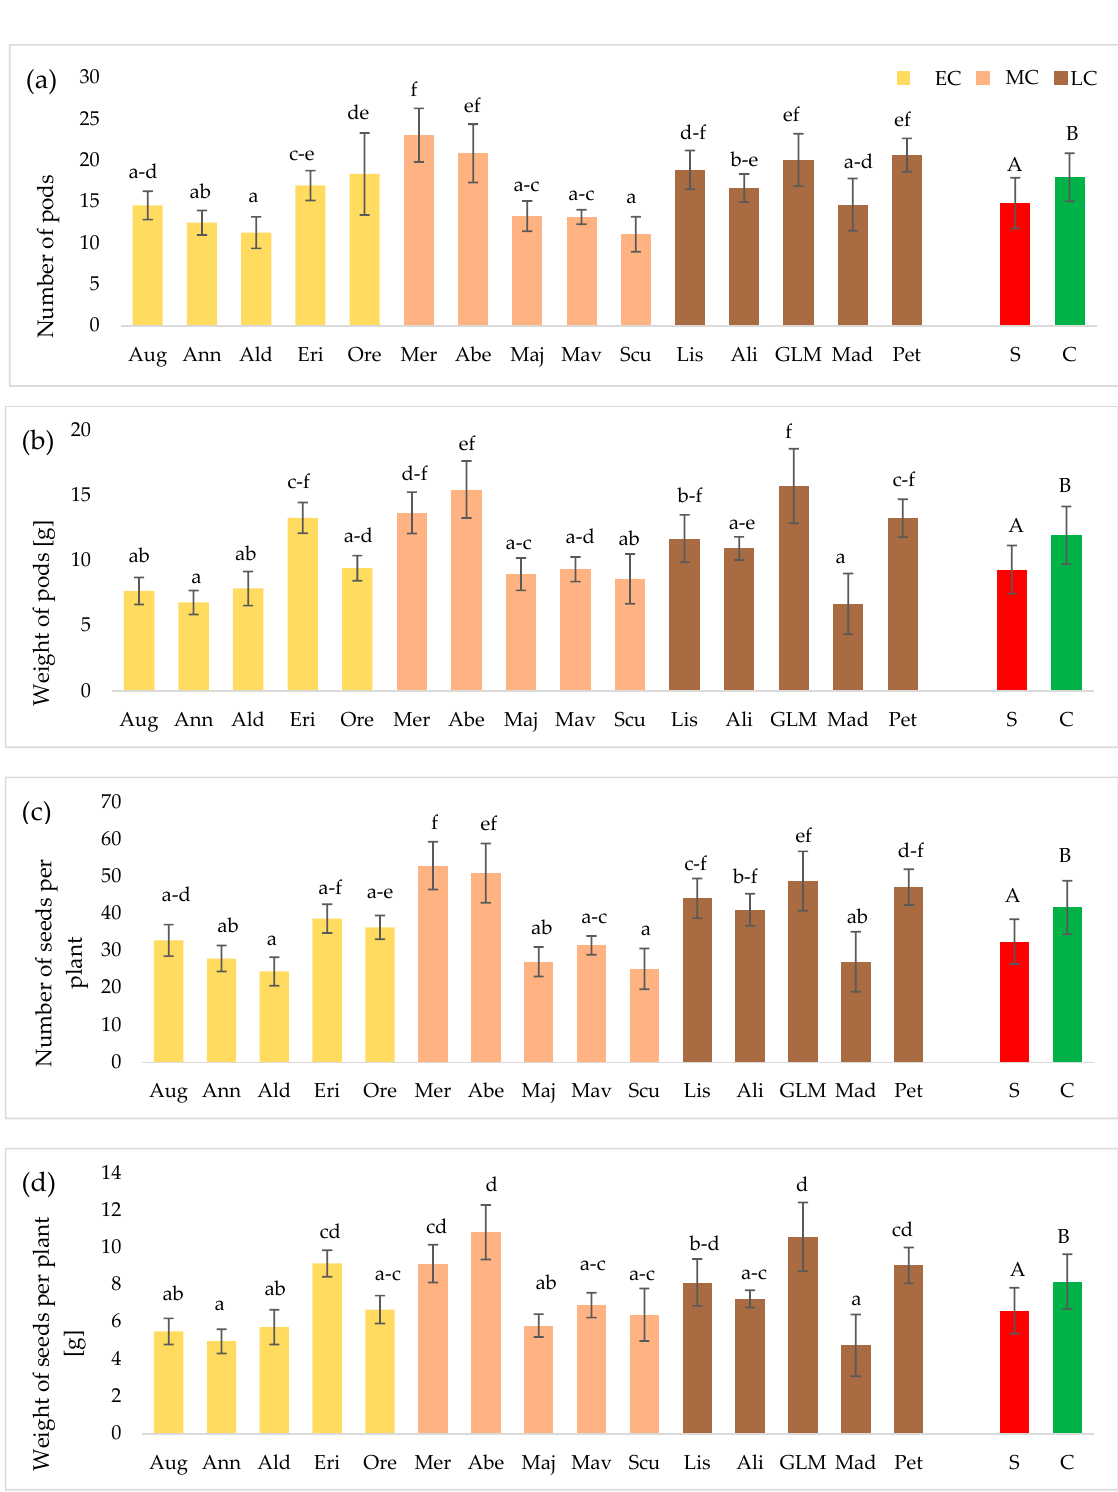
Figure 2. The effects of cold stress (n = 150) and cultivar (n = 20) treatments on the plant structure: number of pods ( a ), weight of pods ( b ), number of seeds per plant ( c ), weight of seeds per plant ( d ). Cultivars: Augusta (Aug), Annushka (Ann), Aldana (Ald), Erica (Eri), Oressa (Ore), Merlin (Mer), Abelina (Abe), Maja (Maj), Mavka (Mav), Sculptor (Scu), Lissabon (Lis), Aligator (Ali), GL Melanie (GLM), Madlen (Mad), Petrina (Pet); EC—very early and early cultivars, MC—medium–early cultivars, LC— late and very late cultivars. Different lowercase letters indicate significant difference between cultivars, different uppercase letters—between treatment (cold stress (S) and control (C)) according to the Tukey test ( p = 0.05); ±SD.